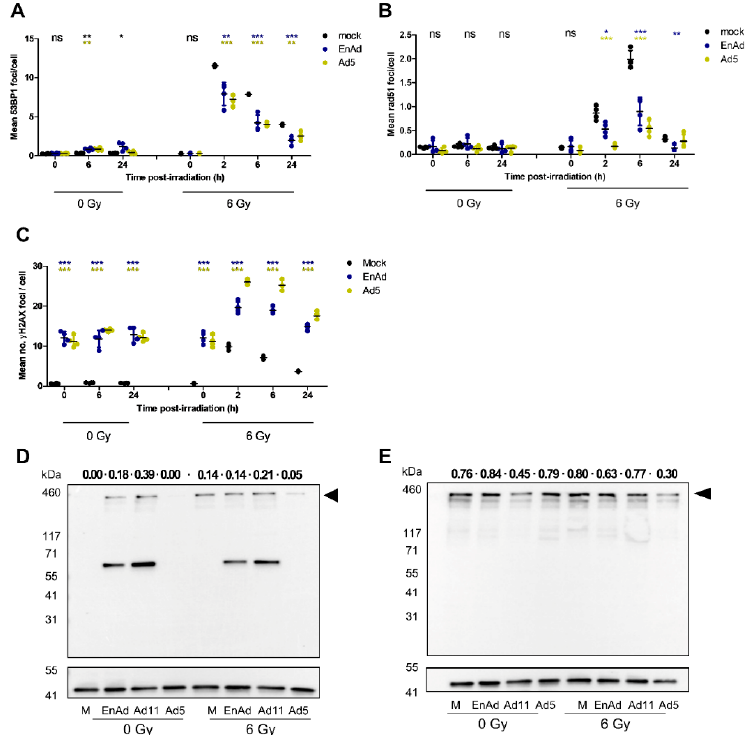
Figure 3 . EnAd modulates the DNA damage response in infected cells. ( A–C ) A549 cells were mock-infected or infected with EnAd-CMV-GFP or Ad5-CMV-GFP at 500 VP / cell. At 24 h p. i., cells were either irradiated at 6 Gy or left non-irradiated. Cells were fixed at di ff erent time points following irradiation and stained for DAPI and 53BP1 ( A ), Rad51 ( B ) or γ H2AX ( C ). Data was acquired and analysed using IN Cell software. Data represent the mean of four biological replicates ± SD of a single experiment representative of three experiments. Significance was evaluated for each time point and virus using two-sided t-test compared to mock-infected control. * p < 0.05, ** p < 0.01, *** p < 0.001. Cells were irradiated 22 h p. i. and harvested 24 h p. i. Cell lysates (20 µ g / lane) were separated by SDS-PAGE and probed using an antibody against Ser1778-phosphorylated 53BP1 ( D ), total